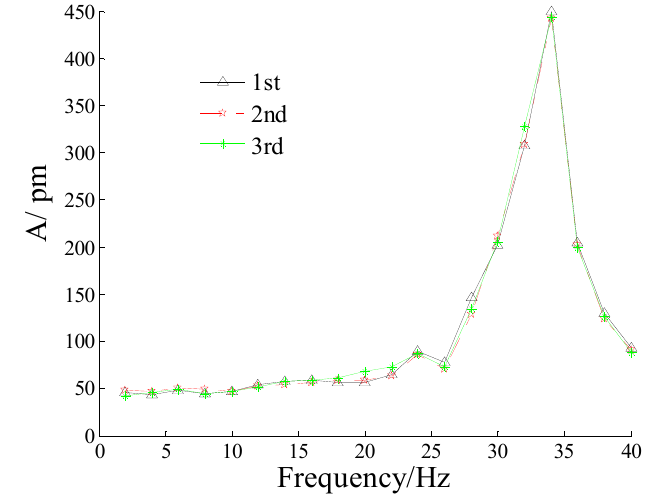
Figure 8. Amplitude-frequency curve of the FBG micro-vibration sensors in the y -direction.